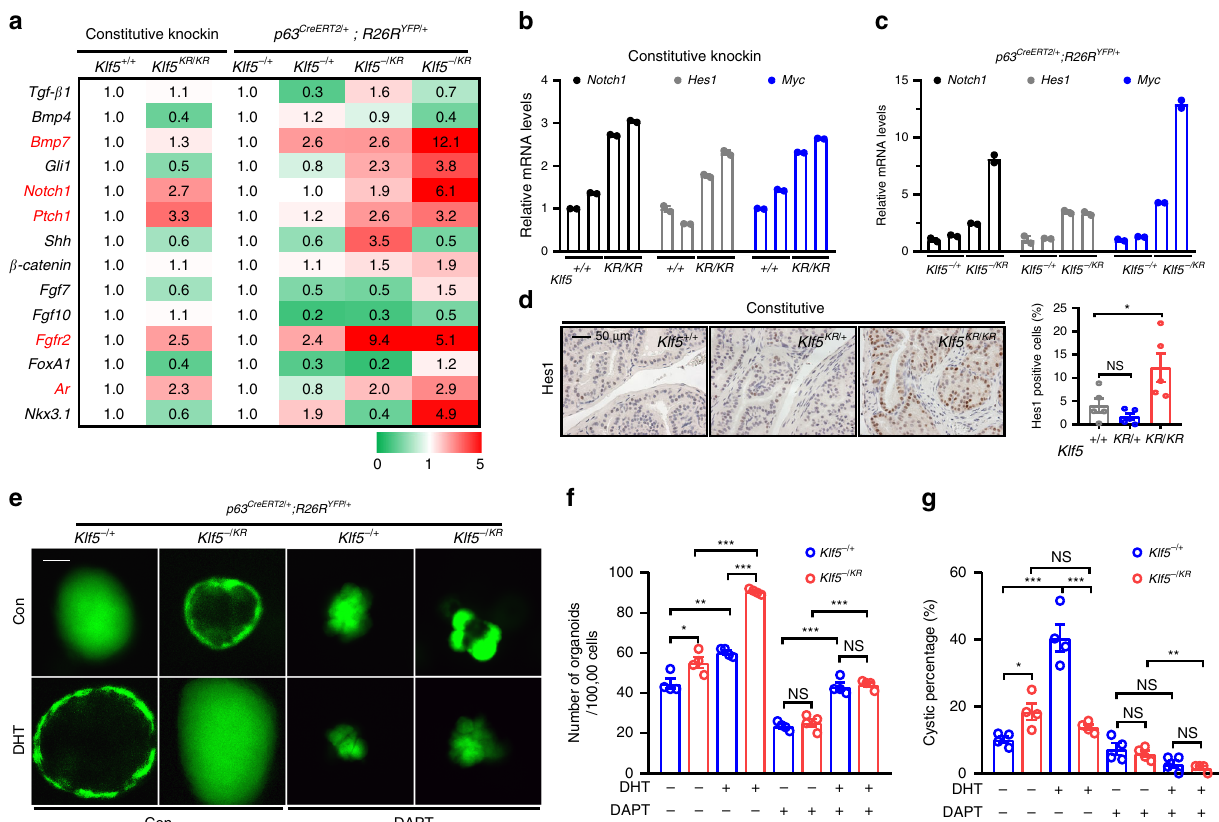
Fig. 6 Deacetylation of KLF5 increases Notch1 signaling activity. a Knockin of Klf5 KR altered the expression of multiple genes underlying prostate development, as detected by a real-time qPCR based screening. Genes highlighted in red showed consistent expression changes between constitutive and induced knockins. Each of the genotypes p63 CreERT2/ + ;R26R YFP/ + ;Klf5 − / + and p63 CreERT2/ + ;R26R YFP/ + ;Klf5 − /KR had 2 samples from different mouse prostates. b – d Knockin of Klf5 KR induced the expression of Notch1 and its downstream target genes Hes1 and Myc , as detected by real-time qPCR in 8-week- old prostates with constitutive ( b ) and induced ( c ) knockins. Experiments were performed in duplicate technically. IHC staining ( d ) was also used to con fi rm increased Hes1 expression in prostates with constitutive Klf5 KR knockin. Five different fi elds were analyzed for each genotype. e – g Inhibition of Notch signaling by the DAPT inhibitor blocked Klf5 KR -promoted organoid formation and eliminated cystic formation. Panel e shows cystic morphology, and panels f and g show statistical analyses. YFP labeled p63 + basal cells from 4-week-old prostates with conditional knockin were cultured with or without DHT. In f – g , n = 4 biologically independent samples. Representative images are selected based on the statistical analysis. Scale bar, 50 μ m. Data are shown in mean ± S.E.M. NS not signi fi cant; * P < 0.05; ** P < 0.01; *** P < 0.001 (two-tailed Student ’ s t -test). Source data are provided as a Source Data fi